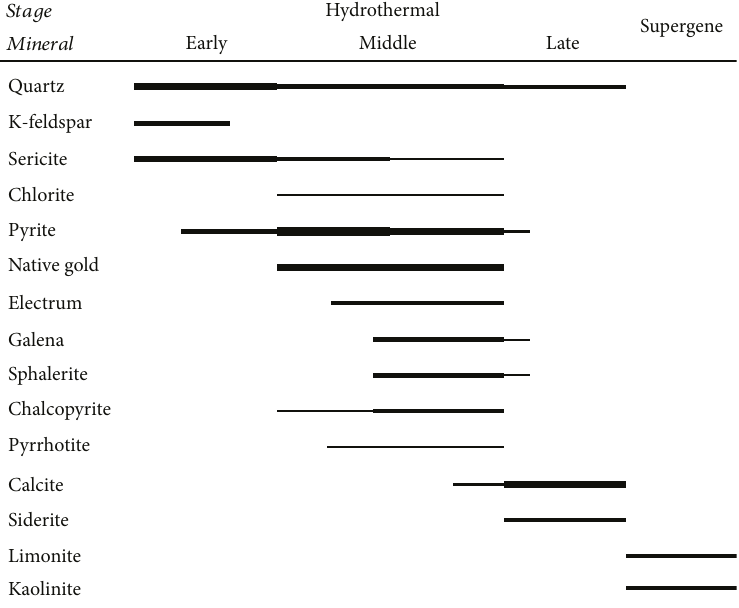
Figure 5: Paragenetic sequence of the main minerals in the Xiejiagou gold